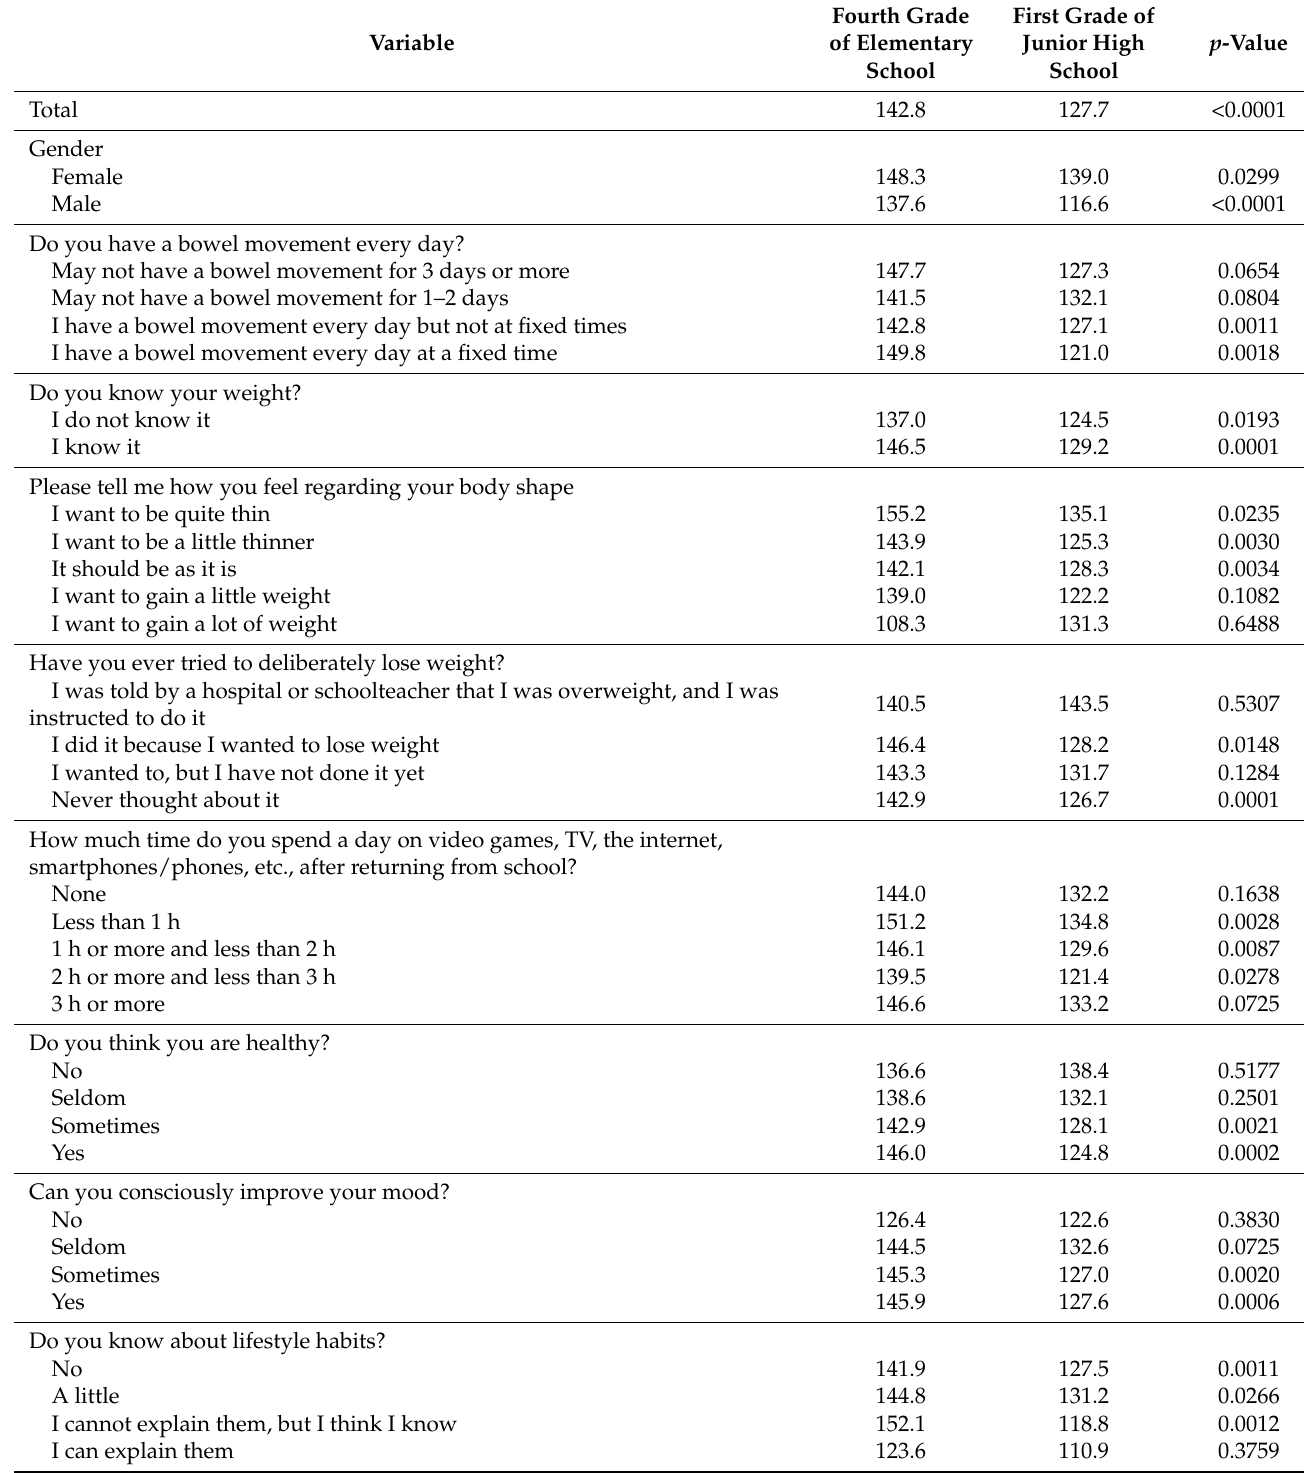
Table 4. t -test comparison between mean total cholesterol levels at two time points.